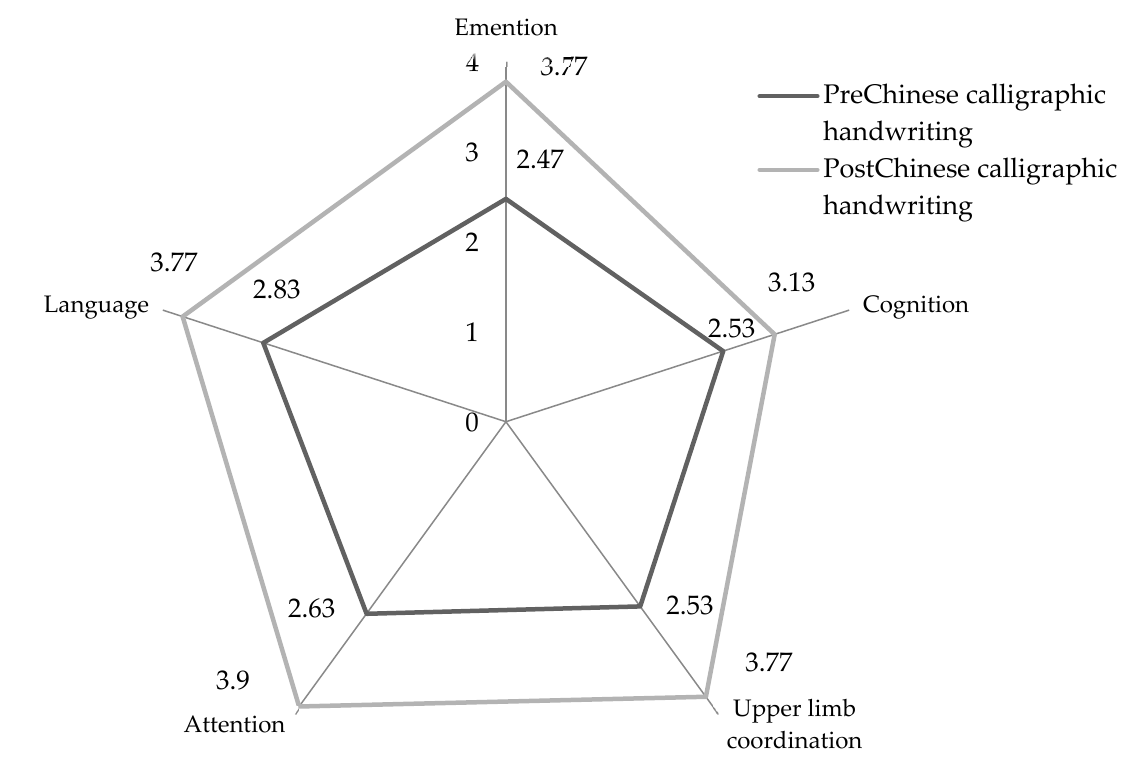
Figure 2. Radar chart showing the mean scores of emotional, memory, and motor functions before and after Chinese calligraphy handwriting